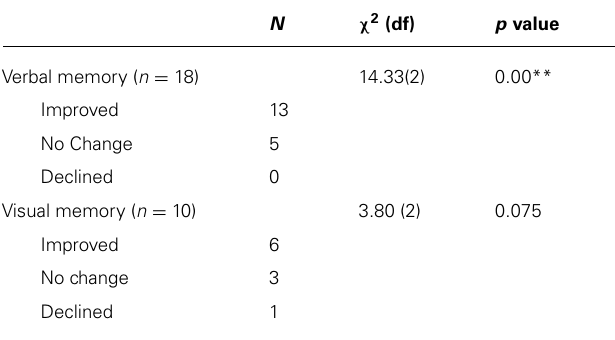
Table 4 | Changes in various cognitive functions before and after